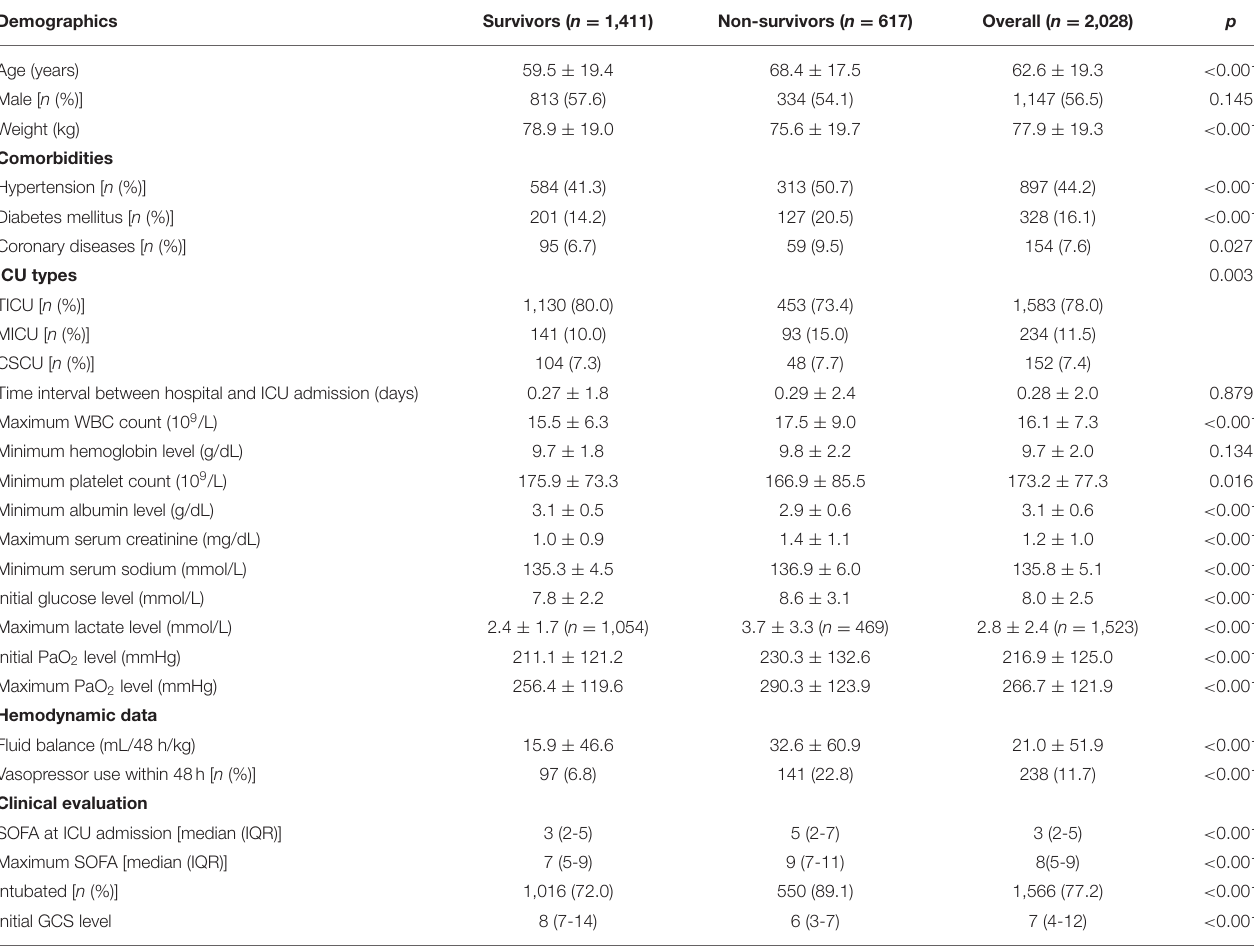
TABLE 1 | Comparison of the characteristics of survivors and